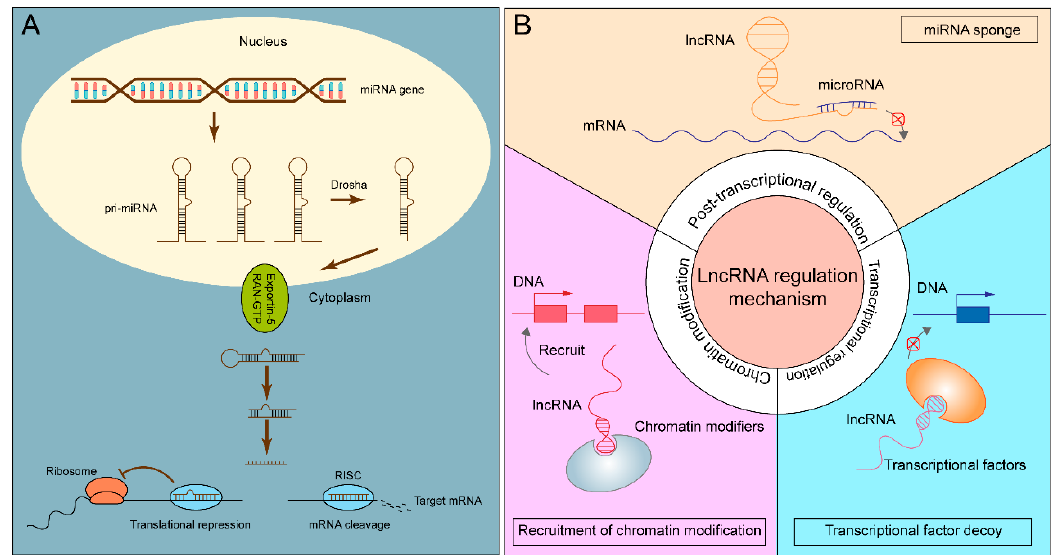
Figure 2. The role of miRNAs and lncRNAs. ( A ) The biogenesis and functional mechanism of miRNAs. ( B ) The regulatory aspects of lncRNAs.